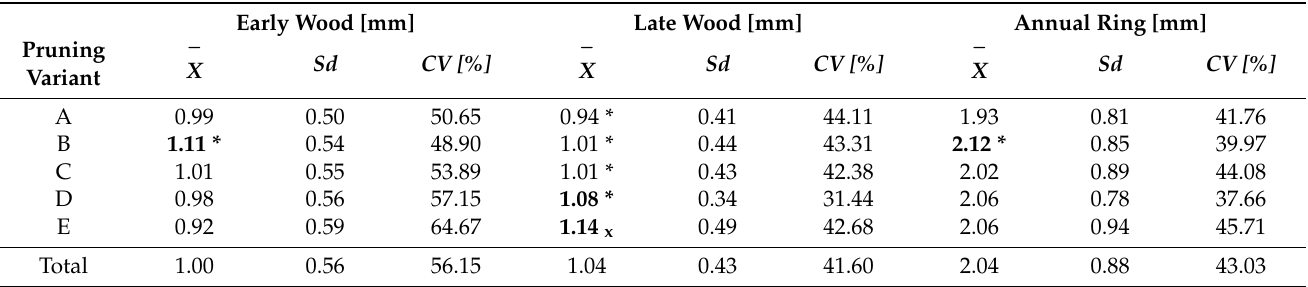
Table 3. Summary of tree increment of analysed Scots pines ( Pinus sylvestris L.) by pruning variant at a stand age of 83 years (68 years after pruning). For details see Table